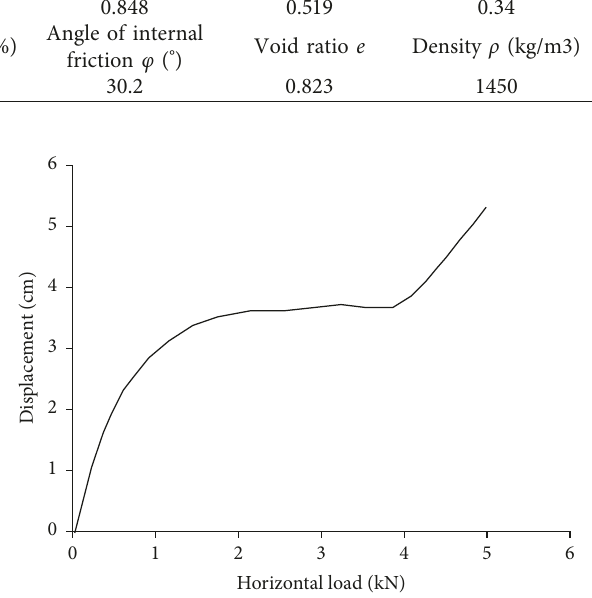
Figure 7: Load-displacement curve of a vertical plate